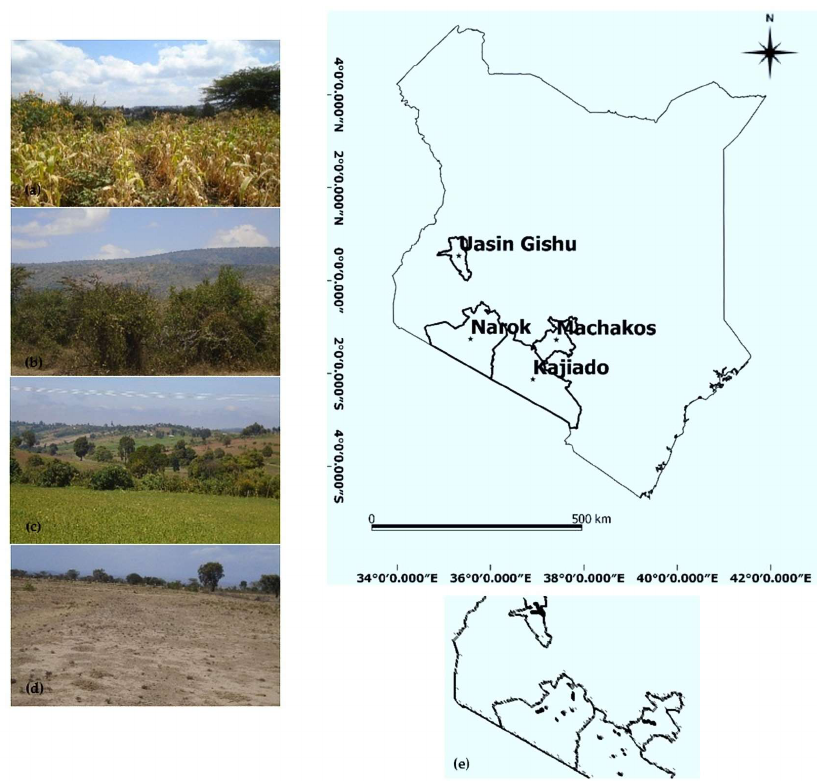
Figure 1. Location of study sites in Kenya: Uasin Gishu, Narok, Kajiado, and Machakos; Typical land use and land cover (LULC) classes in the study site: ( a ) cropland; ( b ) shrubland; ( c ) grassland; and ( d ) bare land; ( e ) in situ measurements